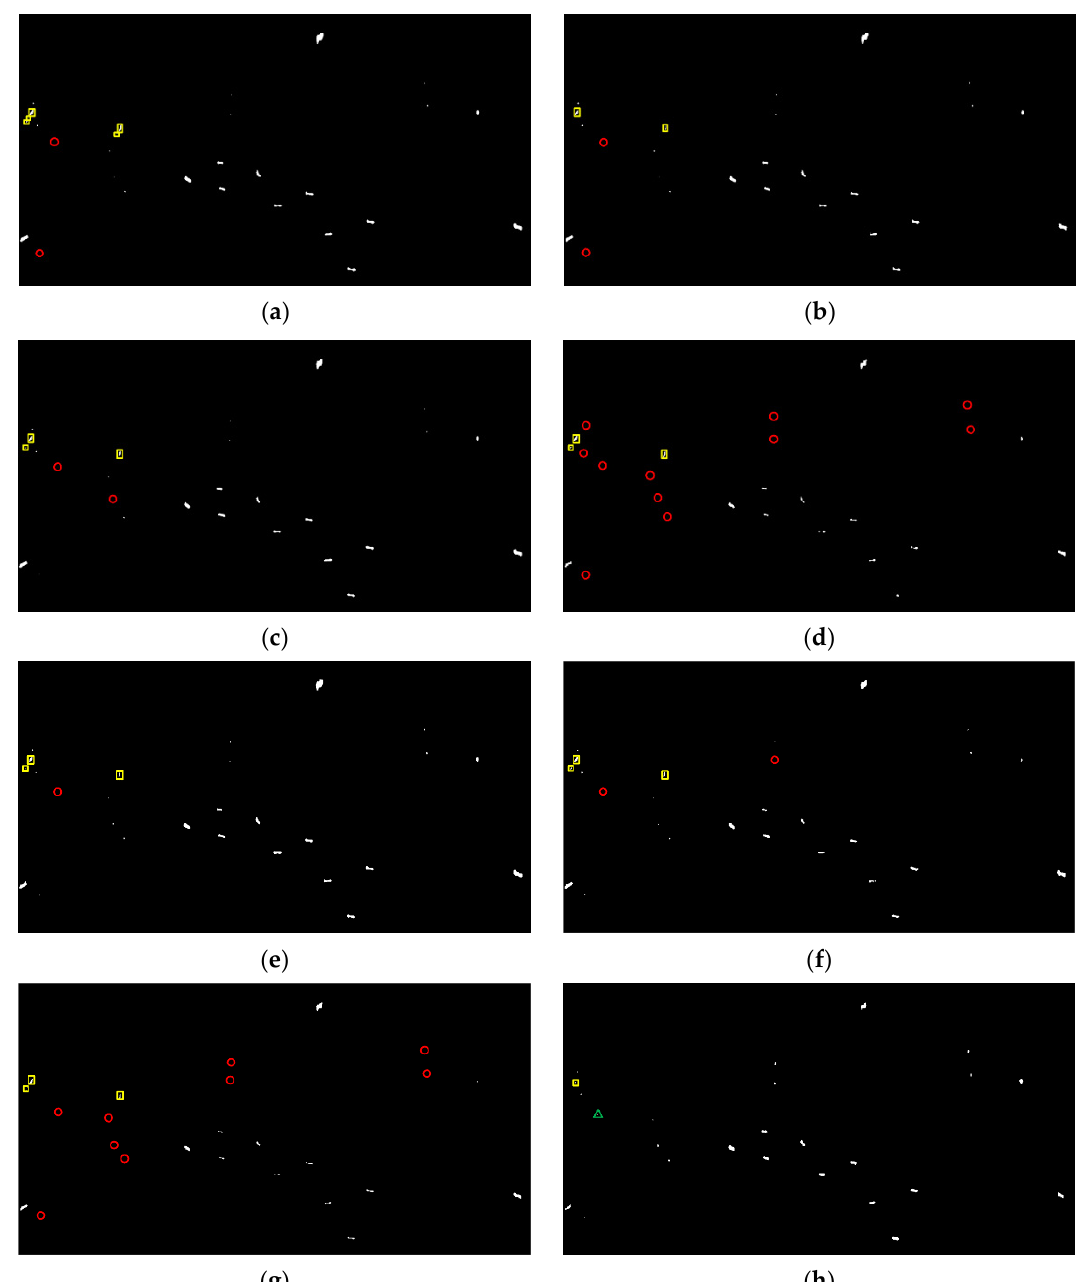
Figure 3. Ship detection results on GF3 data. ( a – h ) The PMS, PNF, Pt-Ps, RS, SPAN, DBSPc, VC-CR, and the proposed method, respectively. The red circles, yellow rectangles, and green triangles out- line the missed targets, false alarms, and barely visible detected ships, respectively.